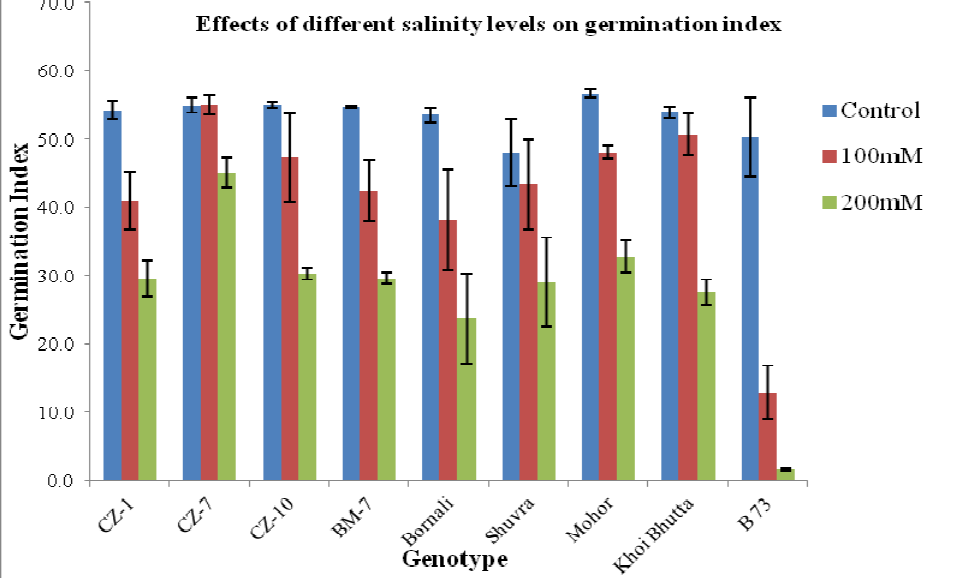
Fig. 3. Effects of different salinity levels on germination index.